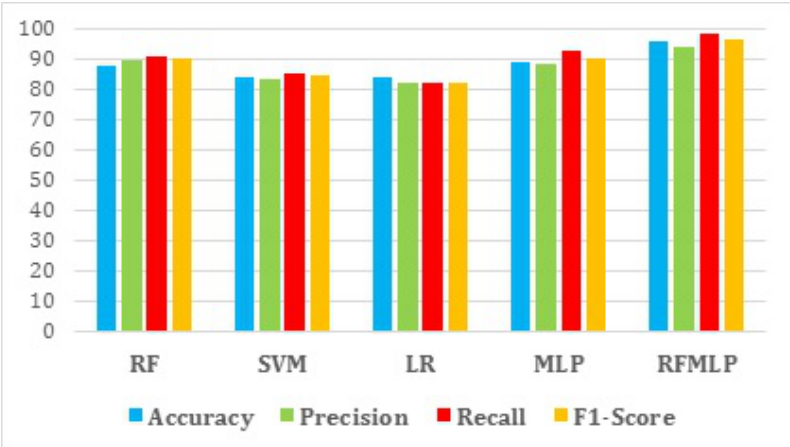
Figure 3. Performance comparison of all models on STIN dataset.